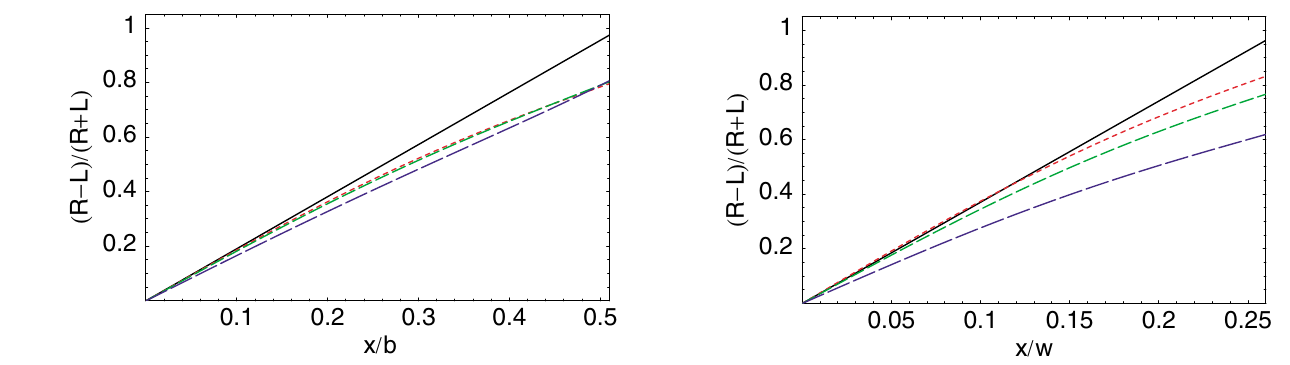
FIG. 4. (Color) Same as Fig. 3, but with (cid:7)